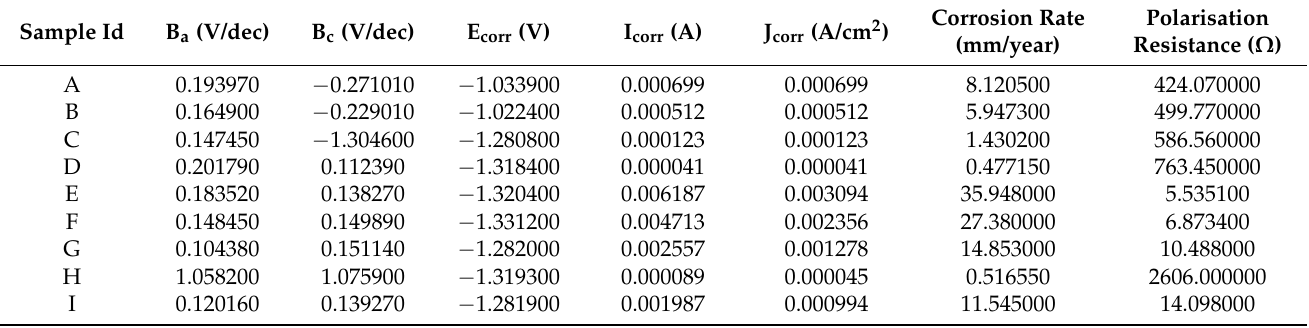
Table 5. Electrochemical parameters that were obtained from the potentiodynamic polarisation test extracted from Tafel plots in Figures 17 and